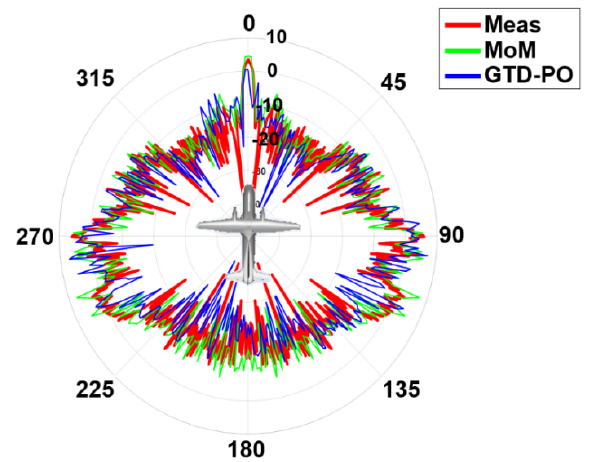
Figure 9. Monostatic RCS results of the airplane mock-up in near-field conditions (polar representation): GTD–PO simulation, MoM simulation, and measurements.